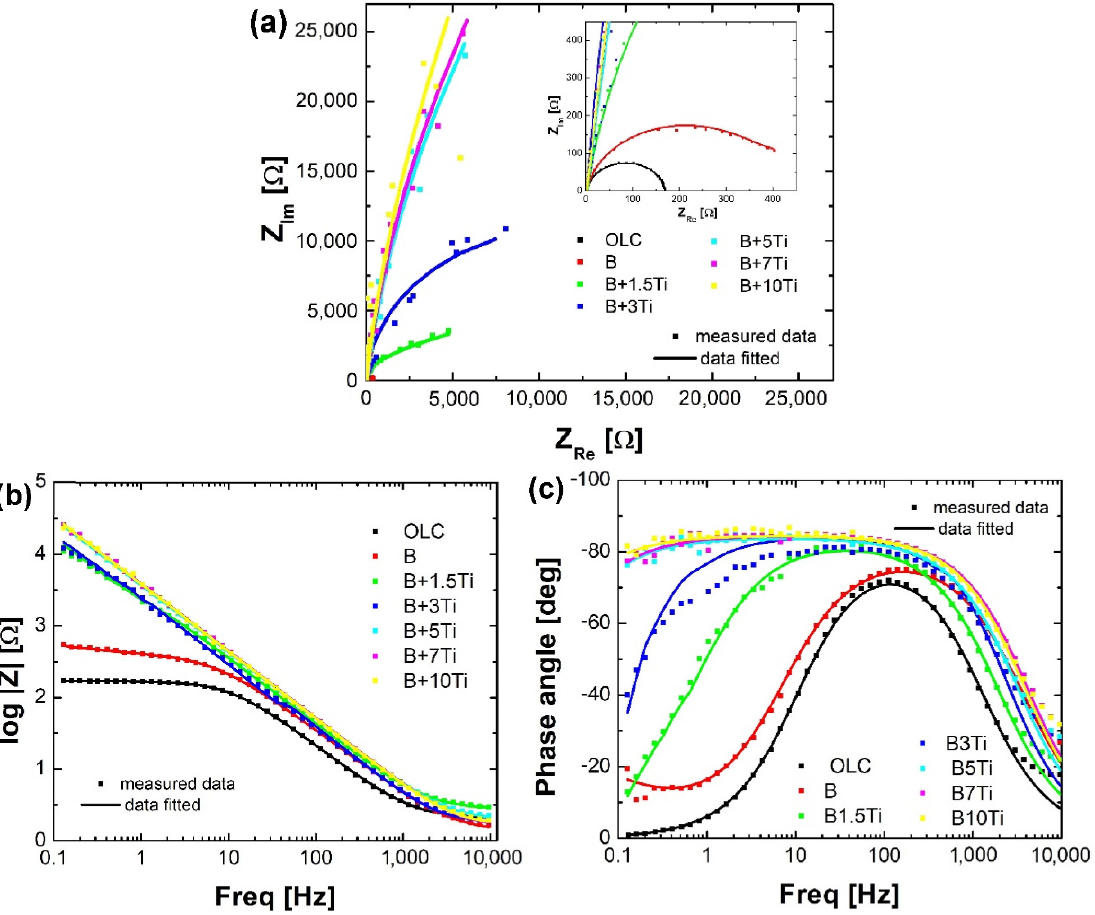
Figure 7. Nyquist ( a ) and Bode plots ( b , c ) of mild steel and NiCr(Ti) coatings on mild steel in H 2 SO 4 0.5 M (pH = 0.3) + 2 ppm F − at 25 ° C. 0.5 M (pH = 0.3) + 2 ppm F − at 25 ◦